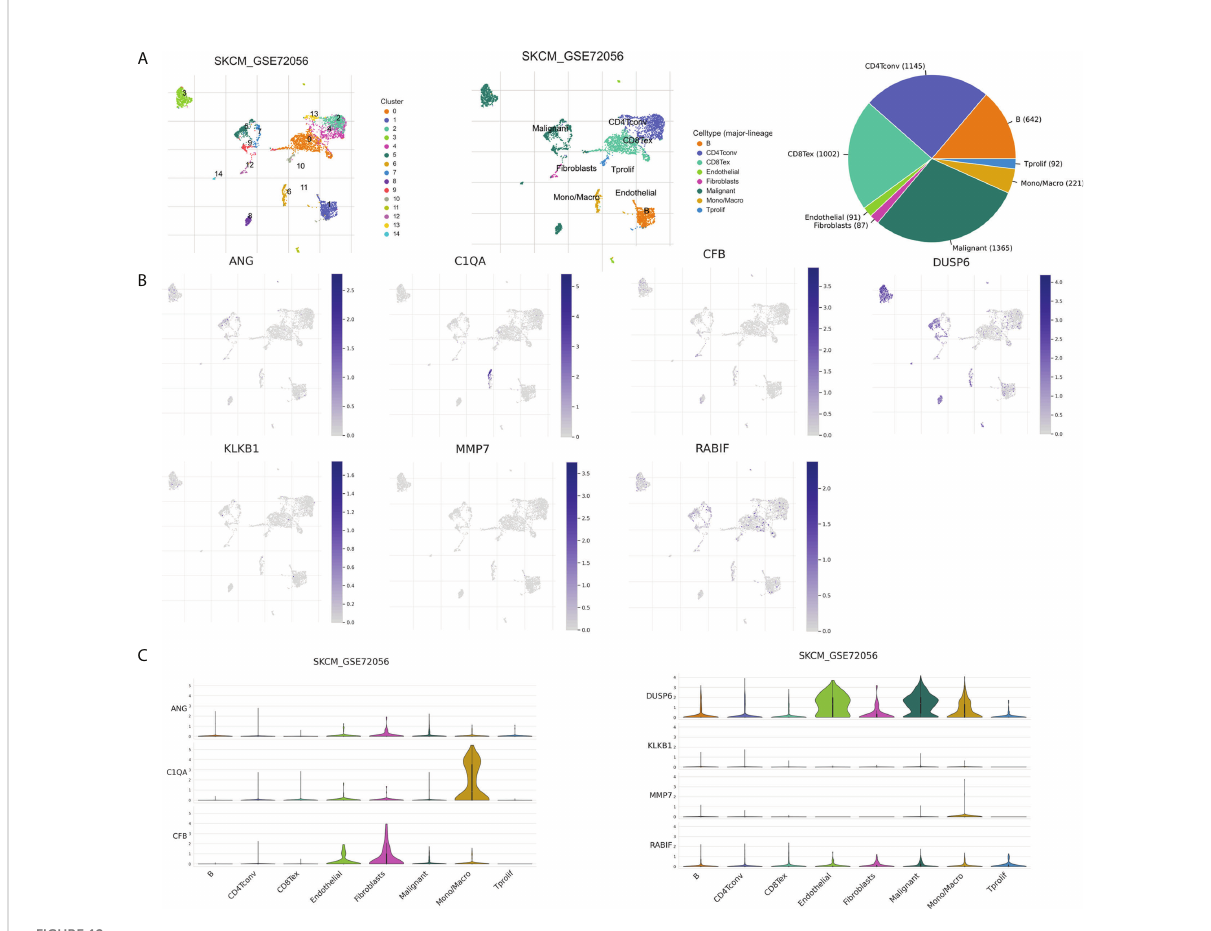
FIGURE 12 CRGs expression in SKCM TME-associated cells. (A) Annotation of diverse cell types and percentages in GSE72056. (B, C) Expressions of ANG, C1QA, CFB, DUSP6, KLKB1, MMP7, and RABIF in different cell types in